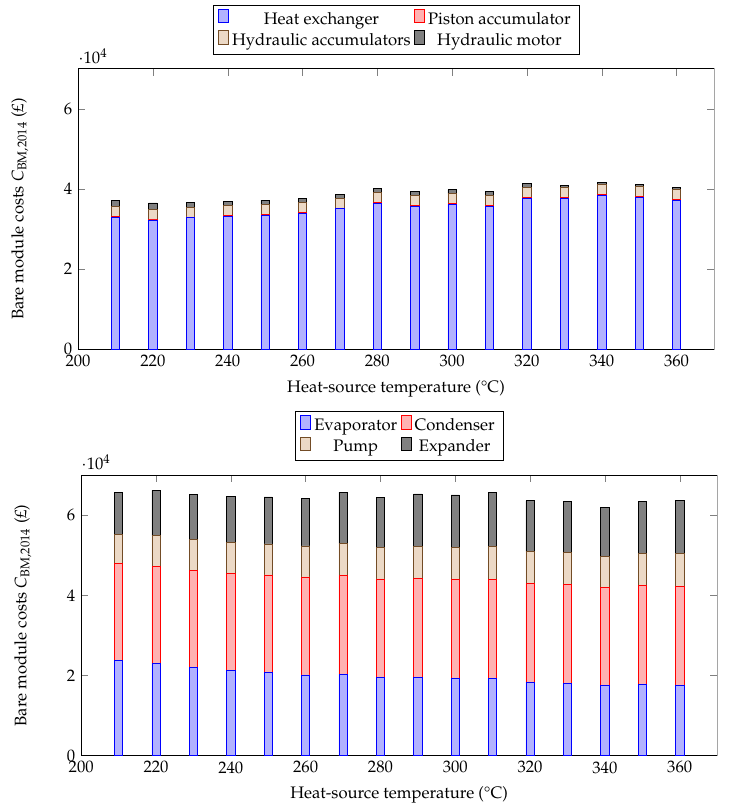
Figure 8. Bare module costs for n -pentane as the working fluid at different heat-source temperatures: ( a ) Up-THERM heat converter; and ( b ) equivalent ORC